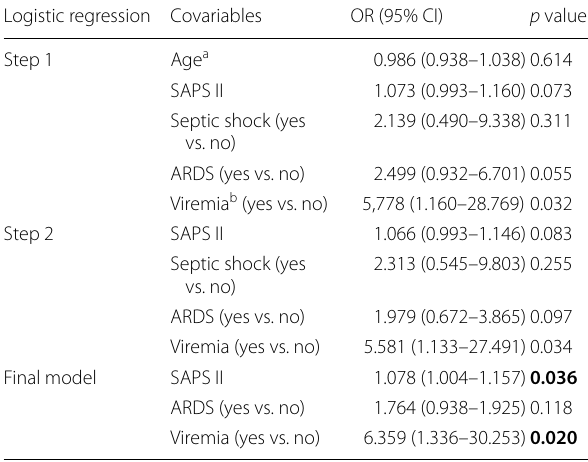
Table 3 Multivariable logistic regression for factors associated with occurrence of severe liver